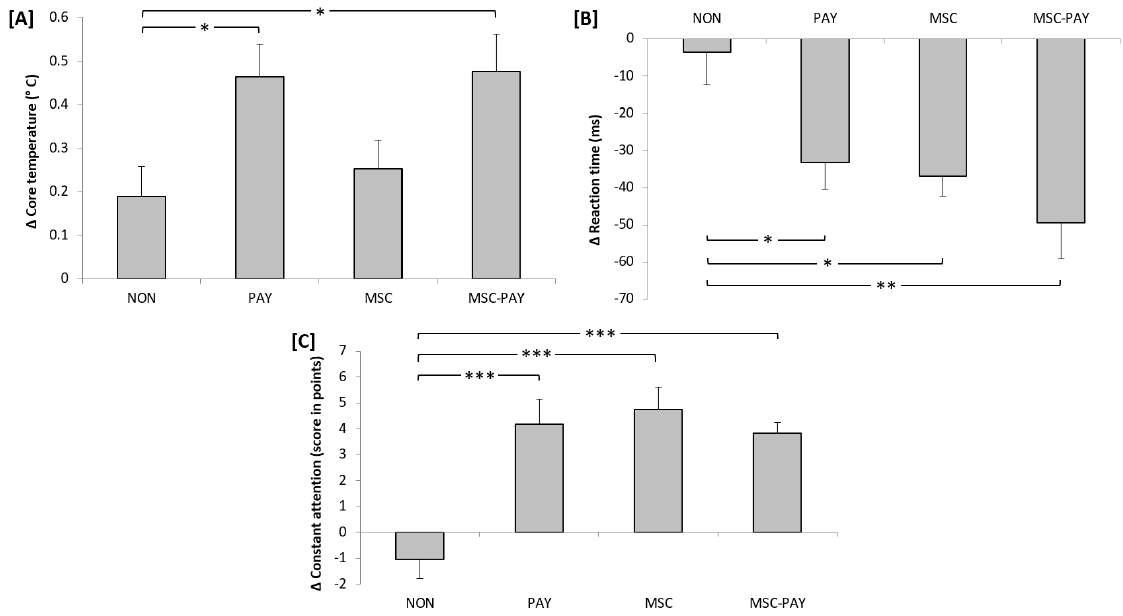
Figure 1. Delta changes in core temperature ( A ), reaction time ( B ), and constant attention ( C ) after four types of activity at recess. * for p < 0.05; ** for p < 0.01 and *** for p < 0.001.